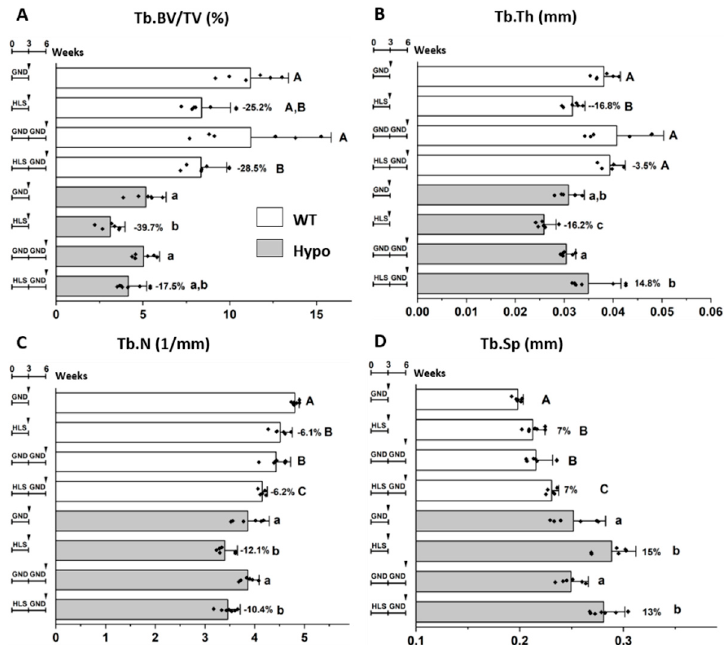
Figure 4. Different trabecular responses of WT and Hypo mice to re-ambulation following